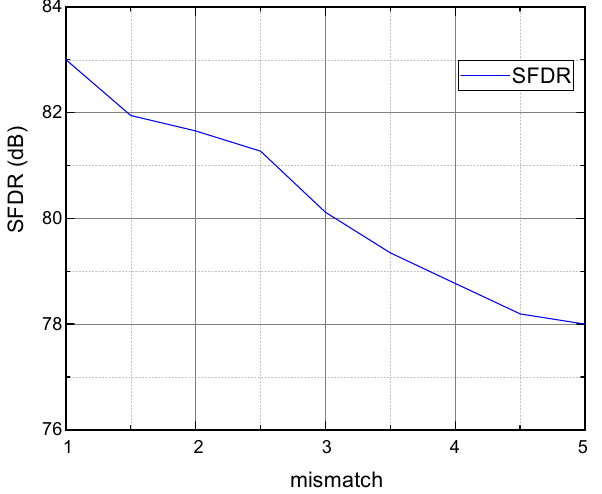
Figure 8. SFDR with different mismatch of sub ‐ ADC 5 MSBs.